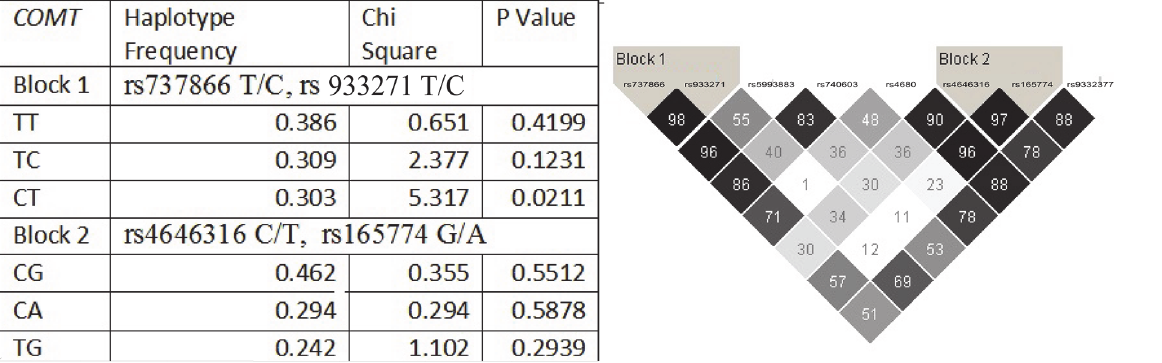
Fig 1. Catechol- O -methyltransferase haplotype blocks composed by single nucleotide polymorphisms evaluated. Two haplotype blocks, with two SNPs each, were defined in Cathecol- O -methyltransferase. Block 1 comprises SNP rs737866 and rs933271 and Block 2 comprises SNPs rs4646316 and rs165774. Darker squares mean the high D prime and high LOD scores. Haplotype blocks were defined with D prime scores higher than 95. When D prime is 100, the number is not shown inside the square. Data shown in the table refers to each haplotypes allele combination association